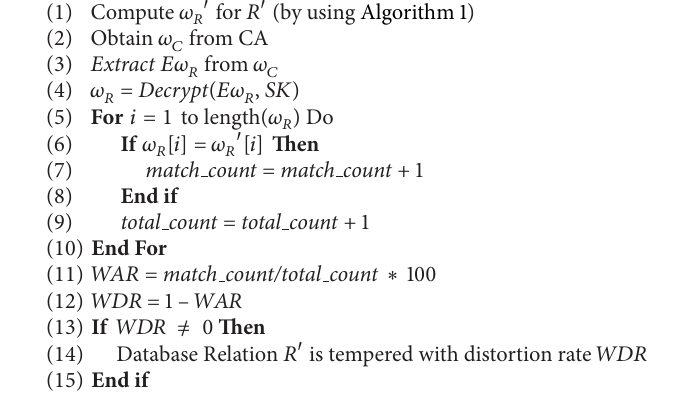
Algorithm 5: Watermark verification.